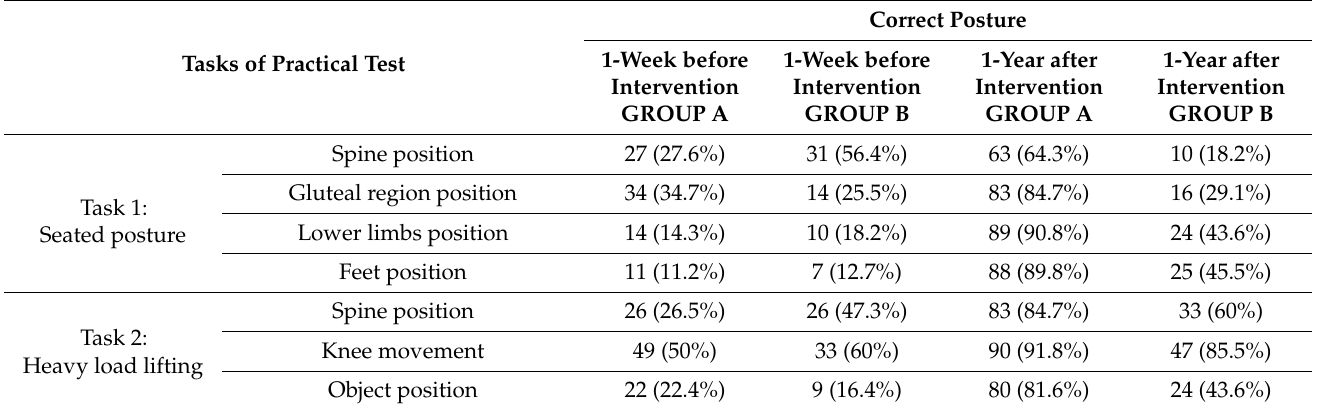
Table 3. Values of practical test by period of evaluations and by intervention